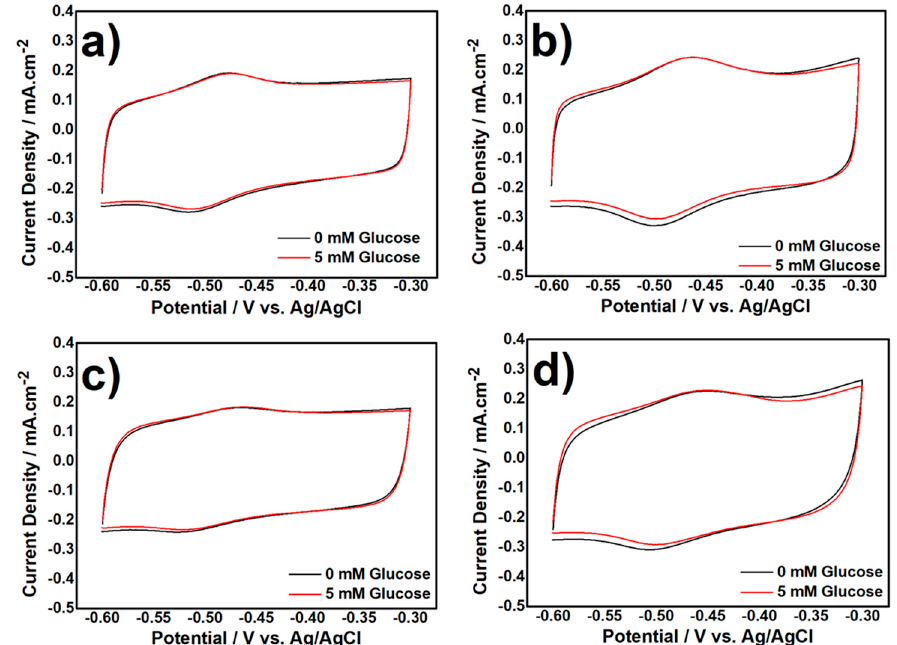
Figure 6. CV curves of ( a ) CNT/GOx and ( b ) CNT/PEI/GOx stored at 4 °C; CV curves of ( c ) CNT/GOx and ( d ) CNT/PEI/GOx stored at 25 °C for 120 days. Scan rate is 100 mV · s − 1 in the absence (black) and presence (red) of 5 mM glucose in the electrolyte. All experiment conducted under aerobic condition in 0.1 M PBS pH 7.4 as the electrolyte.